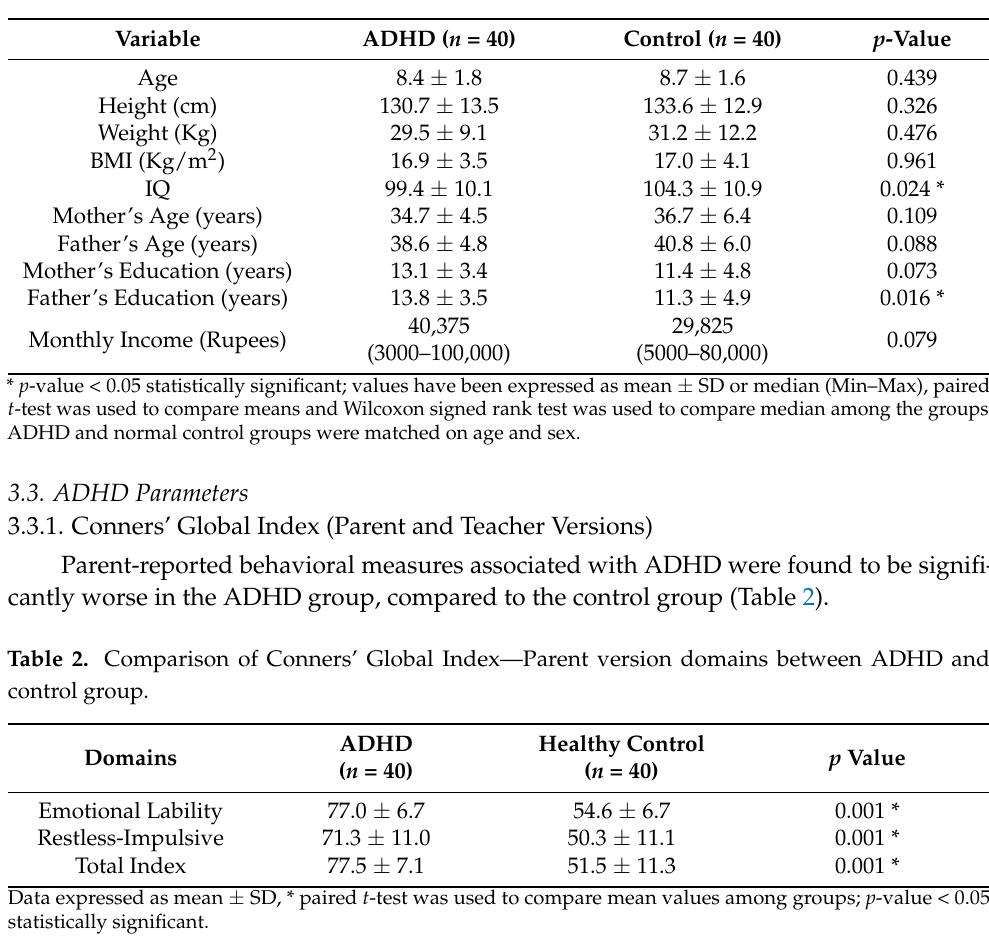
Table 1. Comparison of physical characteristics, IQ, parental demographics, and family monthly income between ADHD and control group.